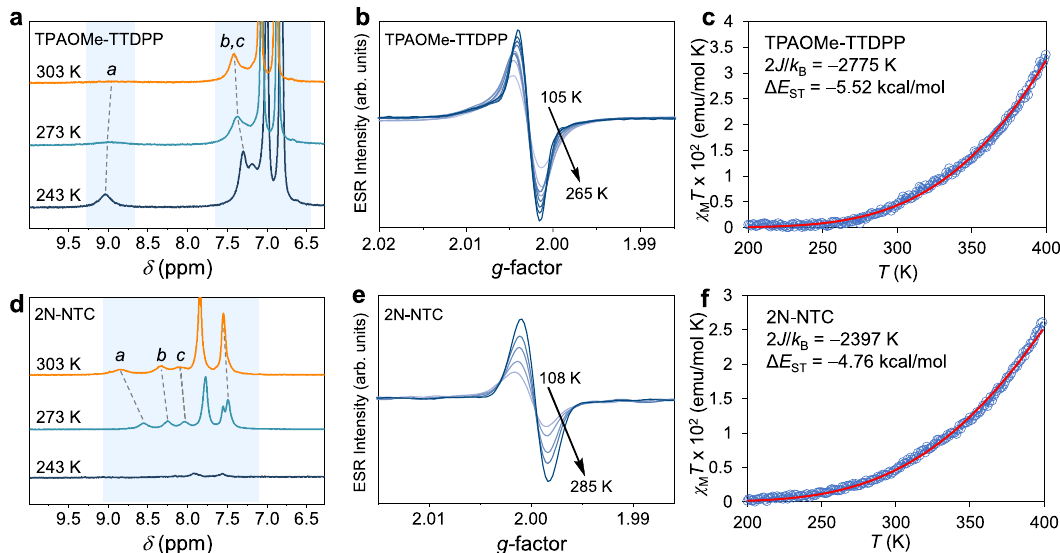
Fig. 4 Temperature dependent properties of TPAOMe-TTDPP and 2N-NTC. a , d Stacked VT 1 H NMR spectra in CD 2 Cl 2 . b VT ESR spectra measured from 152 – 284 K with g = 2.0031 and ( e ) from 105 – 285 K with g = 2.0029. c , f SQUID magnetometry of the solid sample showing magnetic susceptibility times temperature χ M T vs. T from 200 – 400 K, fi t to the Bleaney − Bowers equation with g = 2.003, giving Δ E ST (2 J/k B ) (red line).